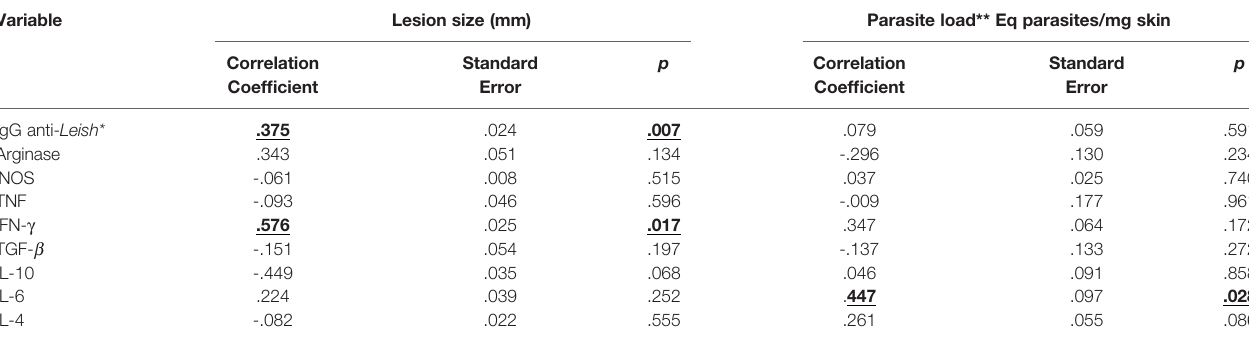
TABLE 1 | Multivariate analysis of factors associated with skin lesion size and parasite load in hamsters infected with Leishmania (Viannia) braziliensis .